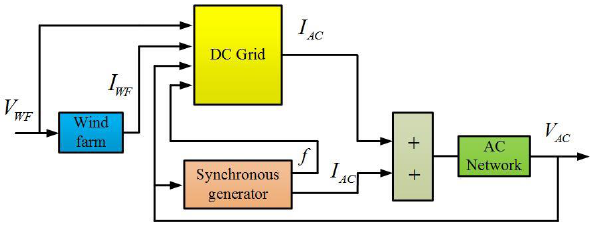
Figure 3. Generic simulation layout.